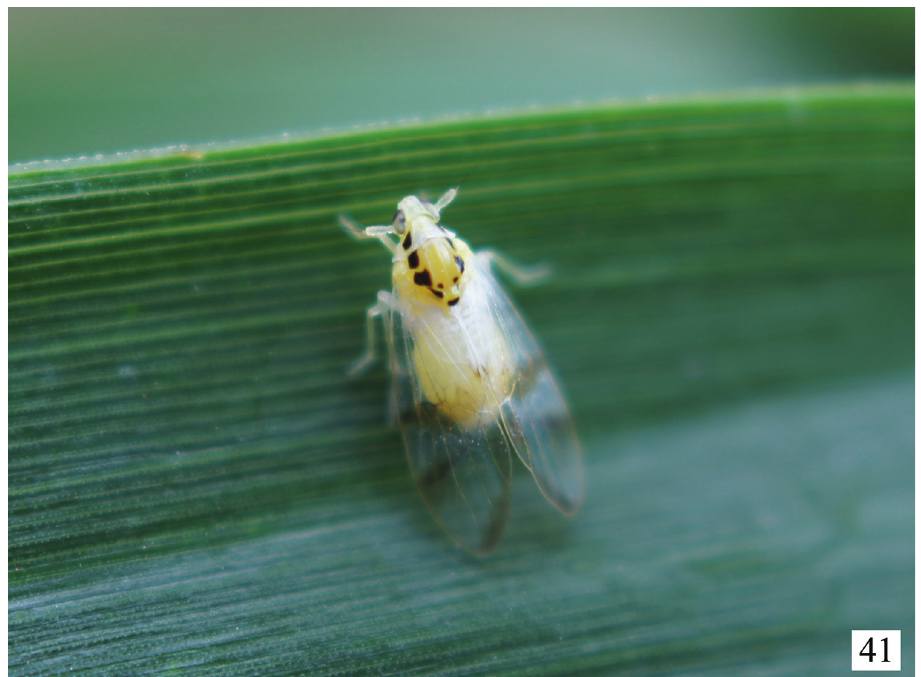
Figure 41. Adult of Bambusiphaga yingjiangensis sp. n. resting on leaf of bamboo. Photograph by X.-S.